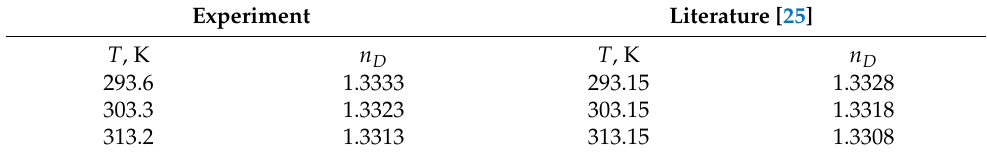
Table 3. Comparison of experimental refractive indices n D of pure water with literature values.